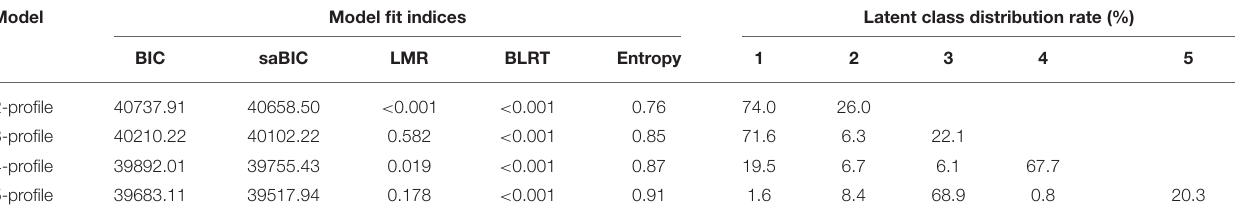
TABLE 1 | Model fit indices of latent profile analysis and distribution rate of social capital ( N = 1,244). Model